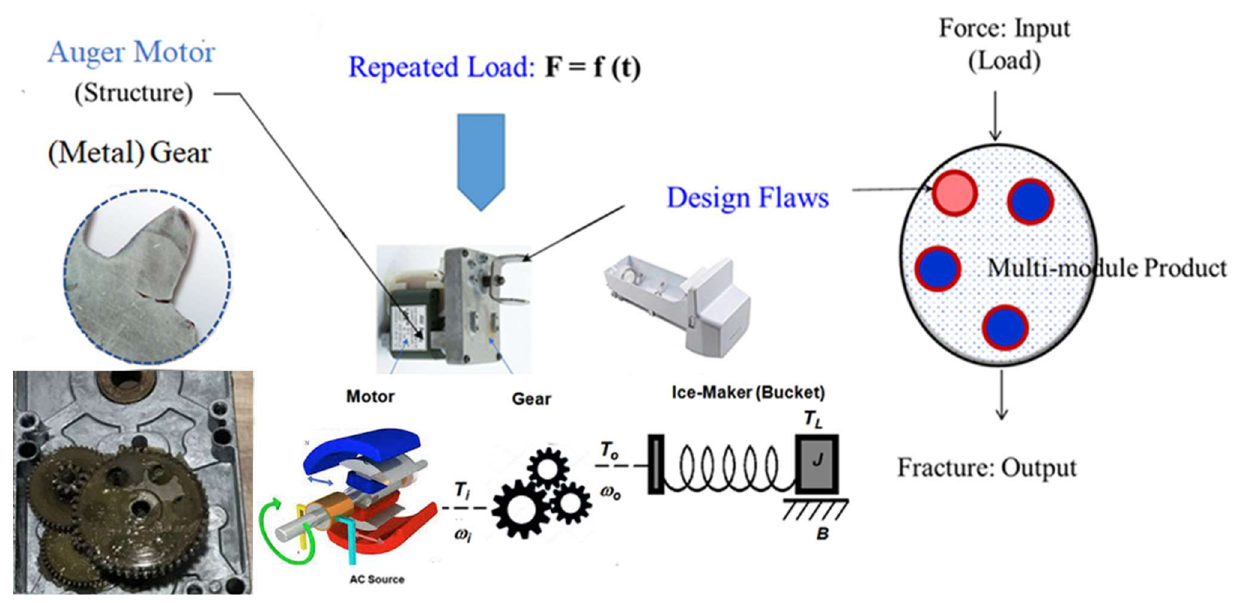
Figure 4. Fatigue failure on the structural component produced by repetitive (impact) load and design imperfections.